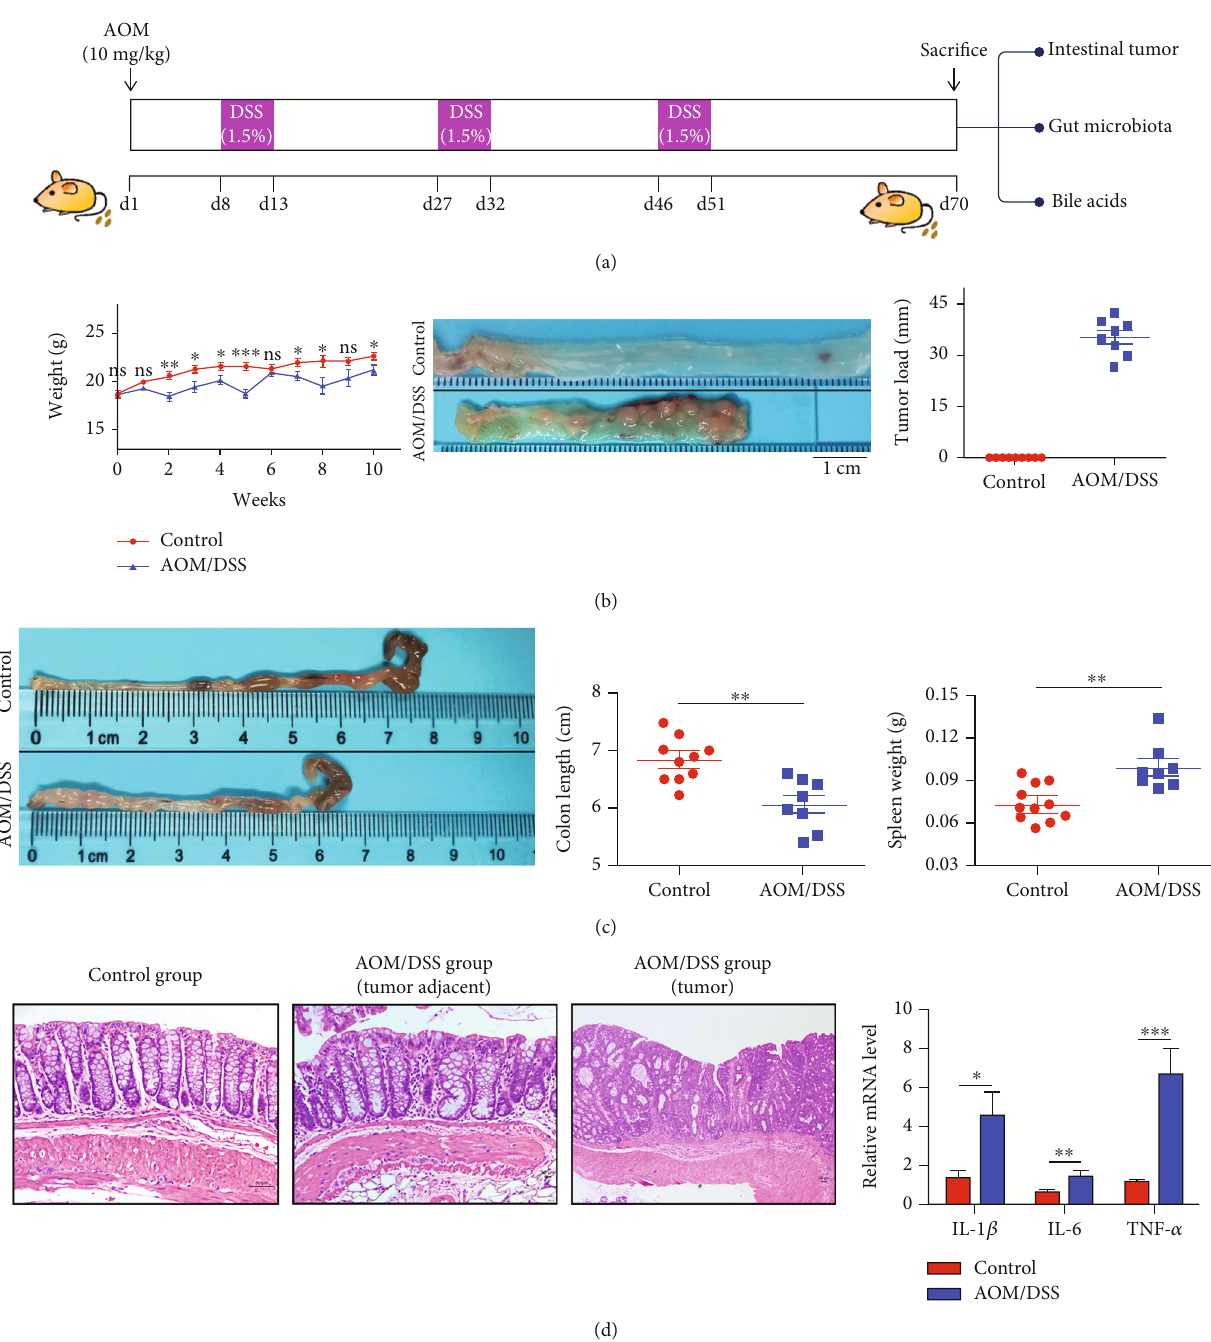
Figure 1: Tumor formation and severe in fl ammatory response in the colon of mice treated with AOM/DSS. (a) Mice received intraperitoneal injection of 10 mg/kg AOM on day 1 and followed by three circles of 1.5% DSS drinking water in the AOM/DSS group. And all mice were killed on day 70. (b) Body weight, colon lumen appearance image, and tumor load of the two groups. (c) AOM/DSS treatment shortened the colon length and increased the weight of the spleen. (d) H&E staining revealed colon tumor formation and in fl ammatory cell in fi ltration in the AOM/DSS group. Real-time PCR showed the increased levels of several in fl ammatory cytokines (IL-1 β , IL-6, and TNF- α ) in the colon. ∗ p < 0 : 05 , ∗∗ p < 0 : 01 , and ∗∗∗ p < 0 : 001 . n = 8